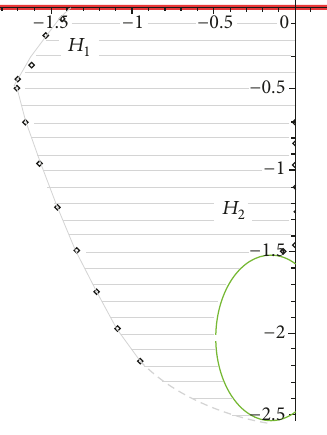
Figure 2: Stability region in 𝐻 1 , 𝐻 2